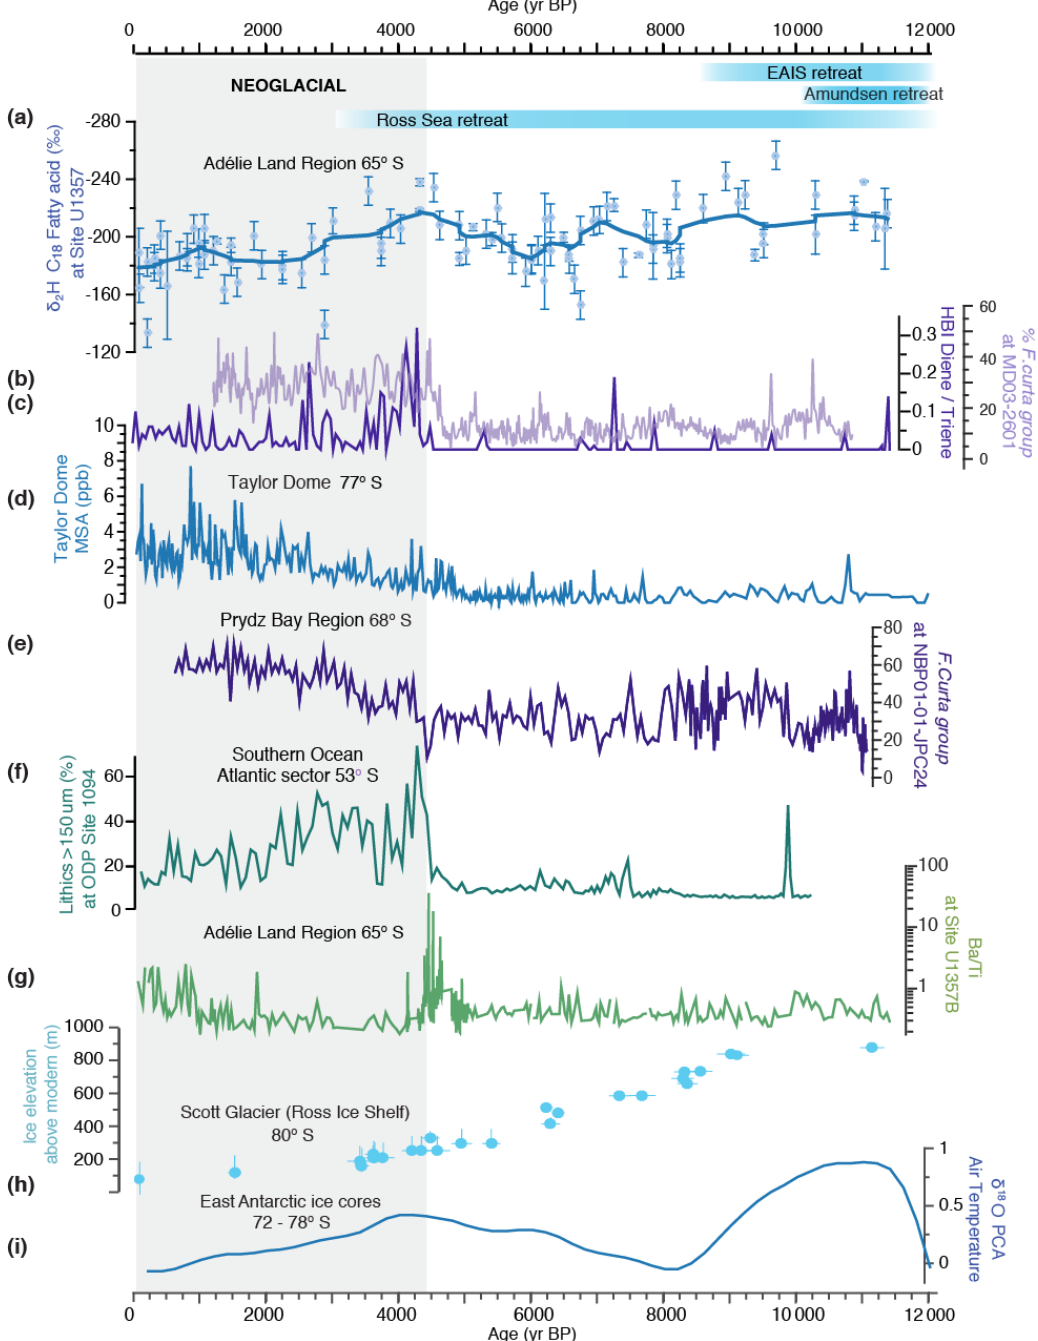
Figure 4. Holocene Adélie Land proxy records from IODP Site U1357 and other circum-Antarctic sites. Glacial retreat chronologies are shown as bars at the top, as discussed in the text. (a) δ 2 H C 18 fatty acid at Site U1357 (errors bars based on replicates), with robust locally weighted smoothing (rlowss). (b) Fragilariopsis curta group ( F. curta and F. cylindrus ) relative abundance at MD03-2601, as a proxy of sea- ice conditions (Crosta et al., 2008). (c) Di-unsaturated HBI (C 25 : 2 ; Diene)/tri-unsaturated HBI isomer (C 25 : 3 ; Triene) ratio at Site U1357. (d) Methanesulfonate (MSA) concentrations (ppb) from Taylor Dome ice core. (e) F. curta group relative abundances in core NBP-01- JPC24. (f) Coarse lithic (ice-rafted) content at TTN057-13-PC4 (Hodell et al., 2001). (g) Ba / Ti (logarithmic scale) at Site U1357. (h) 10 Be cosmogenic nuclide ages from Scott Glacier in the southwestern Ross Ice Shelf region (Spector et al., 2017). (i) Temperature signal from principal component analyses of five δ 18 O records in five East Antarctic ice cores (Vostok, EPICA Dome C, EPICA Dronning Maud Land, Dome Fuji, and Talos Dome) (Masson-Delmotte et al., 2011).